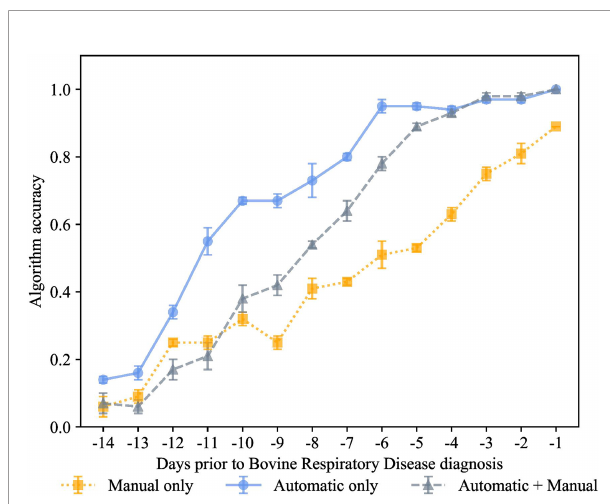
FIGURE 7 | K-nearest neighbor ’ s algorithm accuracy (mean ± SD) with 70% of training and 30% of testing from 10 runs of cross-validation for predicting calves destined for bovine respiratory disease diagnosis using automatically collected features by an automated milk feeder and accelerometer and manually collected features using outward clinical signs of bovine respiratory disease in a 106 dairy calf cohort.